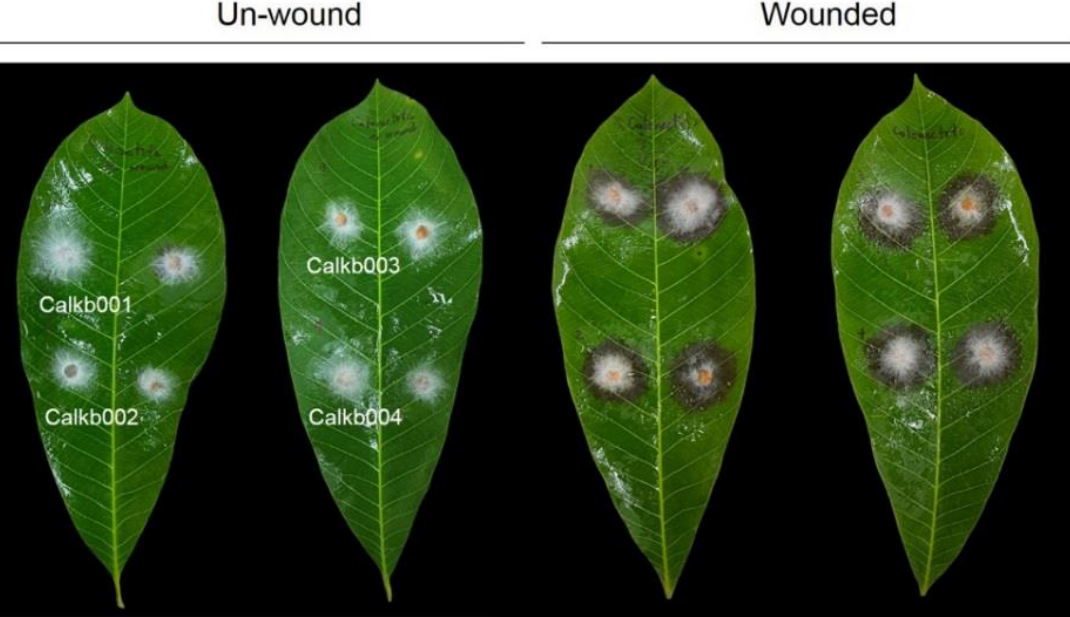
Figure 2. Pathogenicity test of leaf blight symptoms caused by the Calonectria foliicola isolates Calkb001, Calkb002, Calkb003, and Calkb004 on unwounded and wounded rubber tree leaf after 3 days post-inoculation.